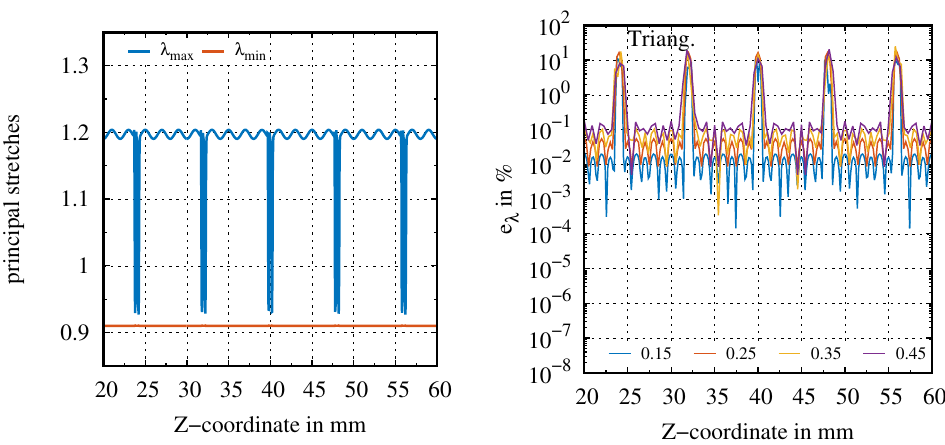
Figure 8. ( left ) Minimum and maximum principal stretches for verification examplewith rough surface, ( right ) relative error of maximum principal stretches using triangulation with different point distances ∆ d = ( 0.15,0.25,0.35,0.45 ) in mm.